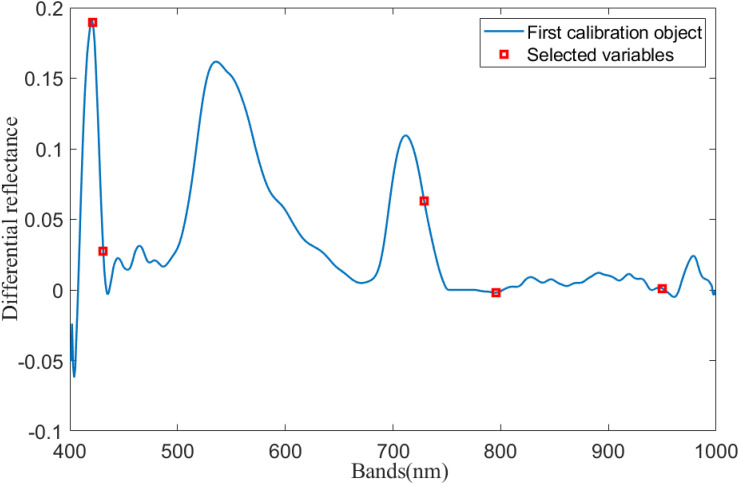
Corresponding spectral band.